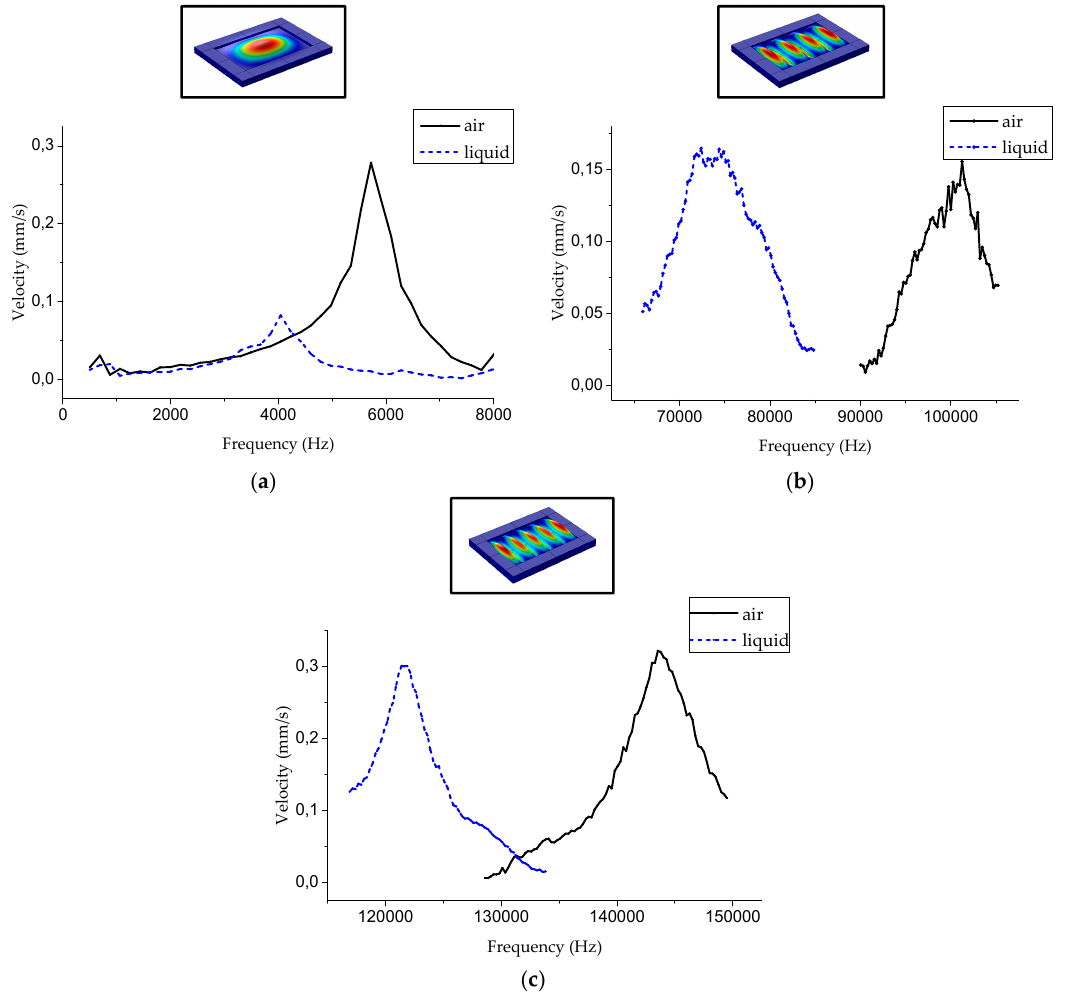
Figure 3. Spectrum of the different modes of interest and identification of the resonant modes from simulation in air and liquid. ( a ) 1st mode; ( b ) Lamb mode with 6 nodes; ( c ) Lamb mode with 8